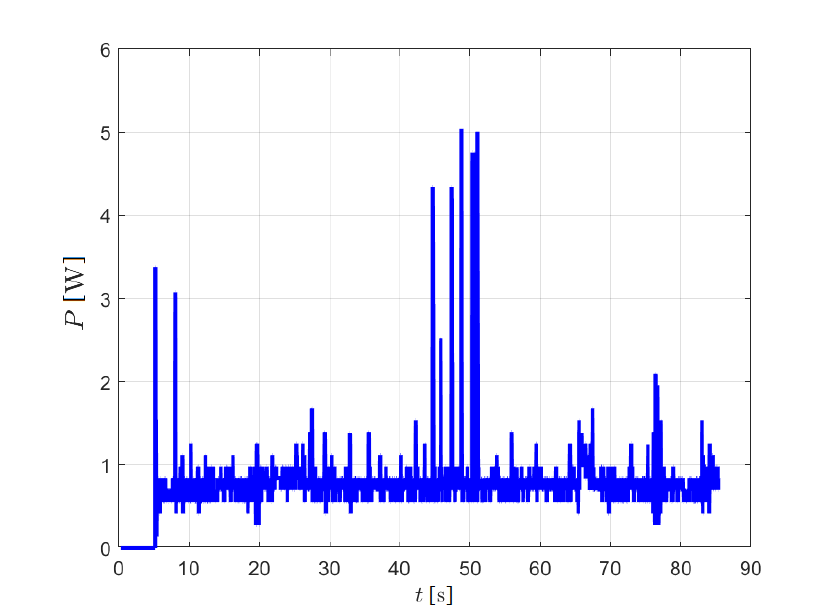
Figure 43. Power P during Map 3 run for the RRT star algorithm of the robot.